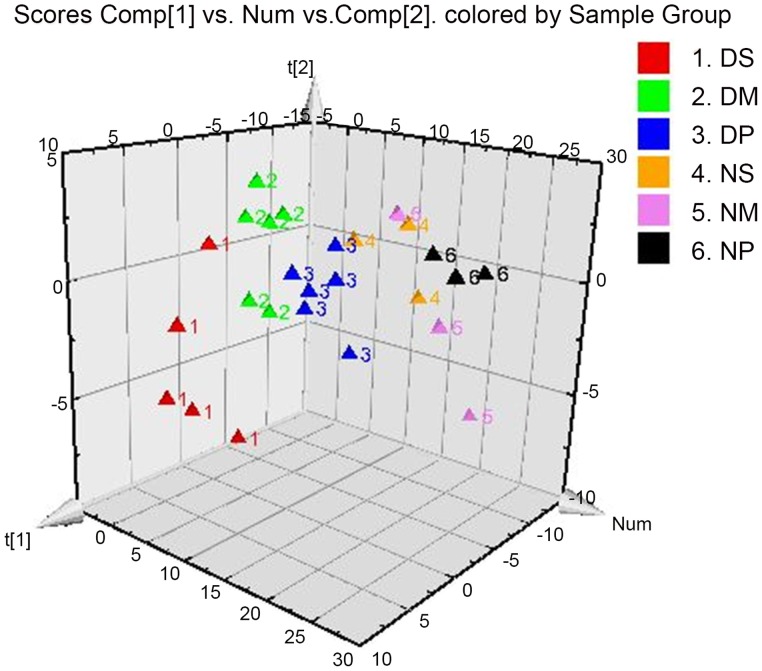
PLS-DA score plot (3D) of PBMC cytokine gene expression between controls and primary dysmenorrhea groups.DS, the secretory phase in the primary dysmenorrhea group (seventh day before menstruation); DM, the menstrual phase in the primary dysmenorrhea group (first day of menstruation); DP, the proliferative phase in the primary dysmenorrhea group (fifth day of menstruation); NS, NM, NP, the secretory, menstrual and proliferative phase, respectively, in unaffected controls.